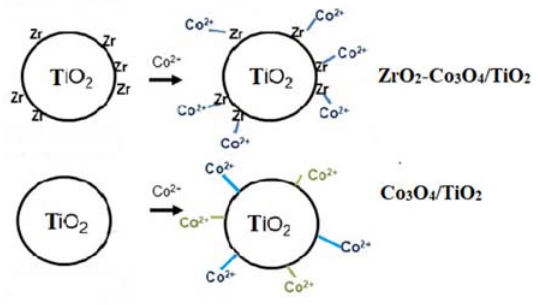
Figure 10. Graphical diagram of 8 wt.% ZrO 2 ‐ Co 3 O 4 /TiO 2 and Co 3 O 4 /TiO 2 .